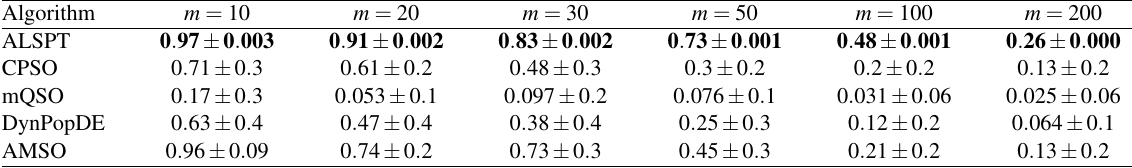
Table 14. gRatio and standard deviation obtained by ALSPT and four population-based state-of-the- art algorithms in the MPB benchmark for different number of